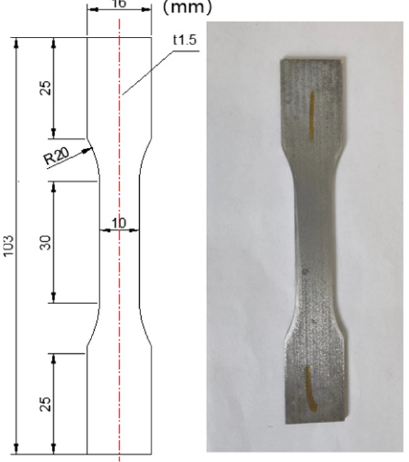
Figure 1. Size of the tensile specimen.